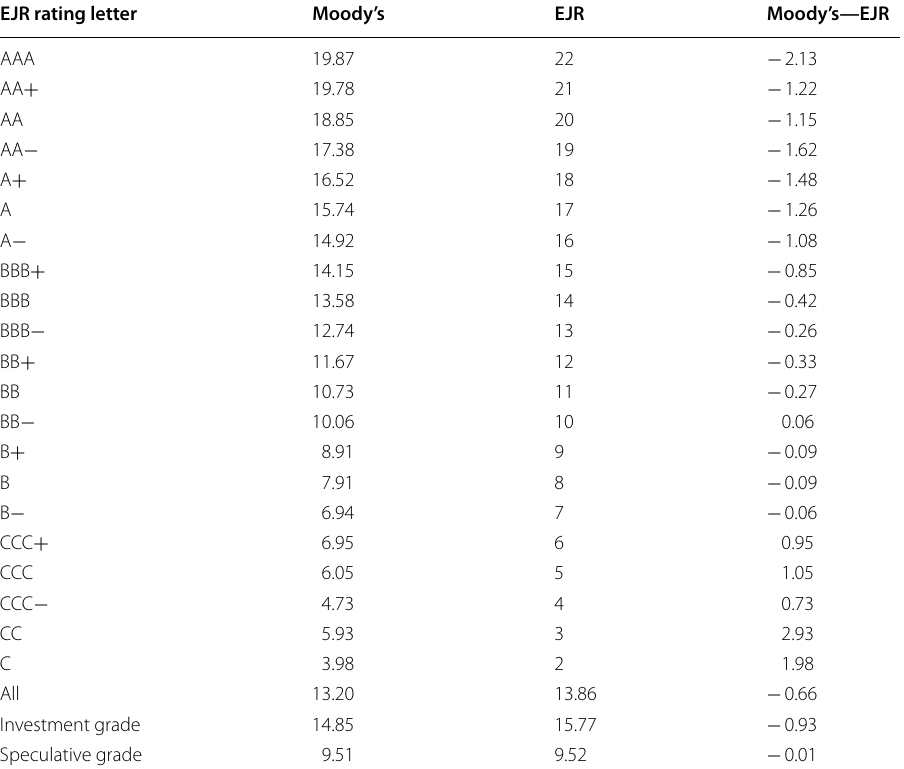
Table 2 The average ratings of Moody’s and EJR by rating